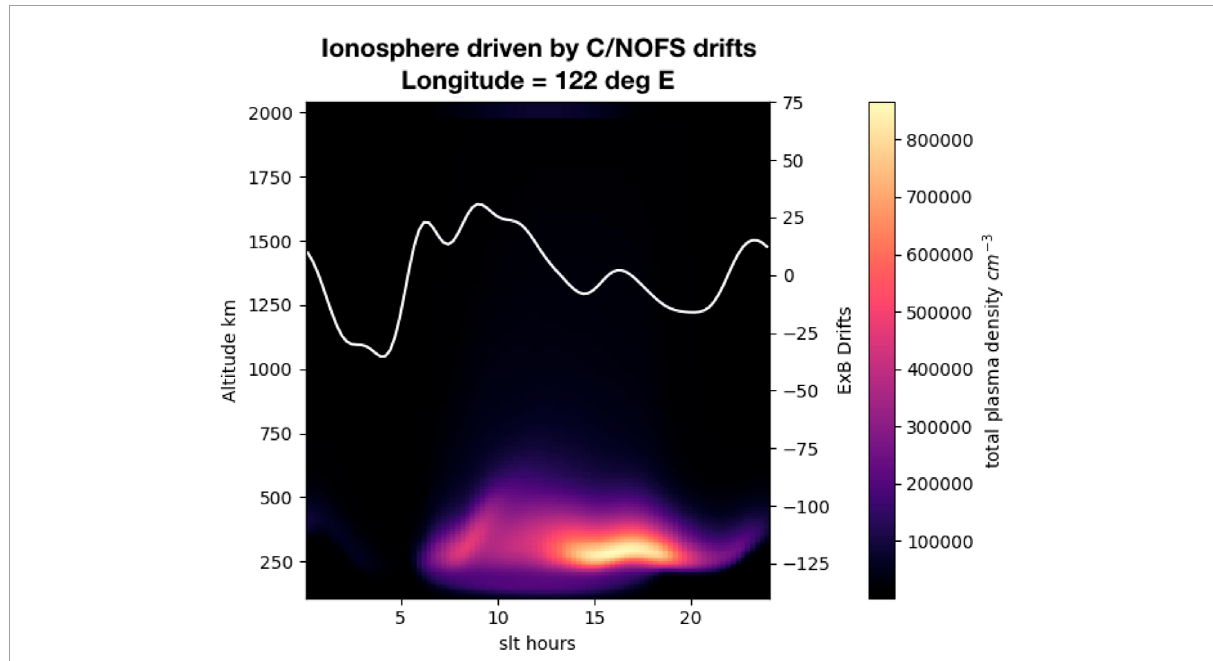
FIGURE 5 Example output ionosphere driven by custom drift climatology fit to C/NOFS data.